Question: Describe this figure in one sentence.
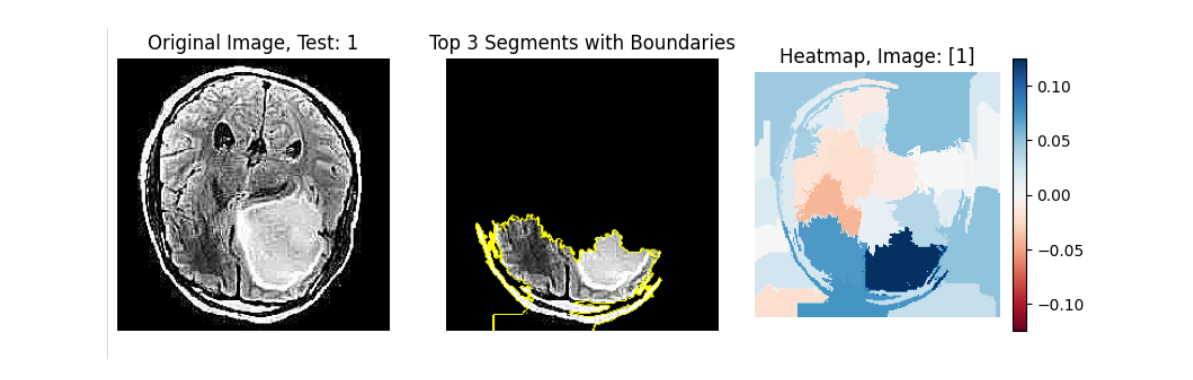
Answer: Top segments contributing to the prediction, with the produced heatmap from LimeImageExplainer